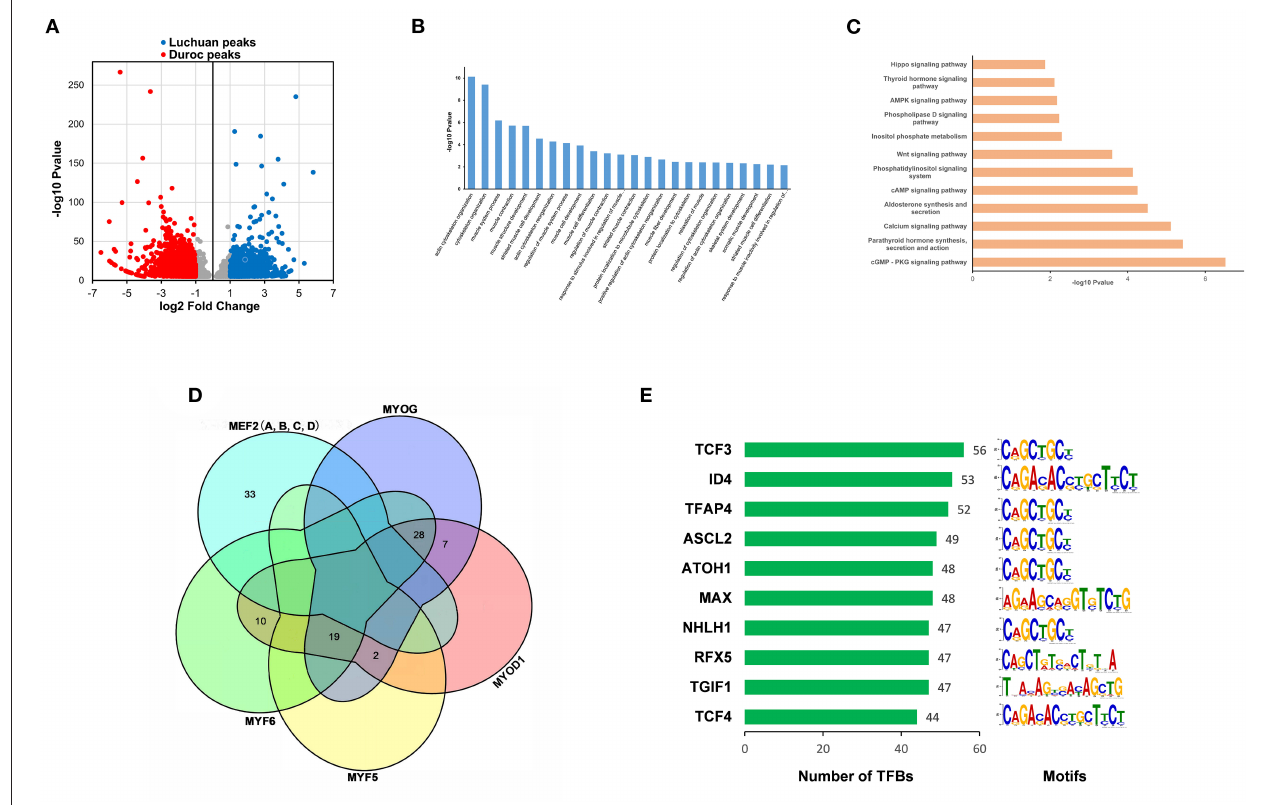
FIGURE 3 | Different peaks corresponding to target gene enrichment analyses and transcription factor prediction. (A) Scatter plot of differential peaks ( P < 0.00001, |log 2 (fold change)| ≥ 1). (B) GO enrichment analysis of target genes corresponding to different peaks. (C) KEGG pathway enrichment analysis of target genes corresponding to different peaks. (D) Unified Venn diagrams of predicted binding sites of star factors (MRFs and MEF2s) involved in the regulation of muscle development according to motif alignment. (E) Predicted transcription factors. Left, the number of co-binding sites between the predicted transcription factors and the star factors. Right, the motif type of the transcription